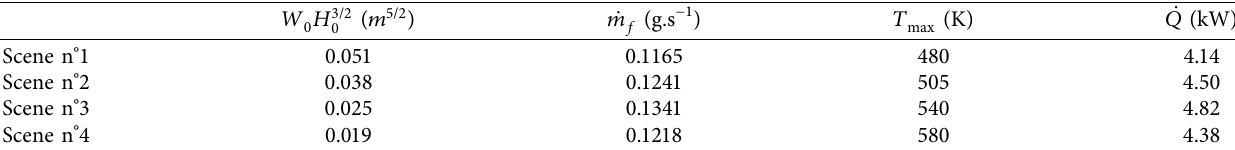
Table 5: Results of experimental tests including the mass loss rate of fuel, higher temperature of hot gases, and the heat release rate of the fire